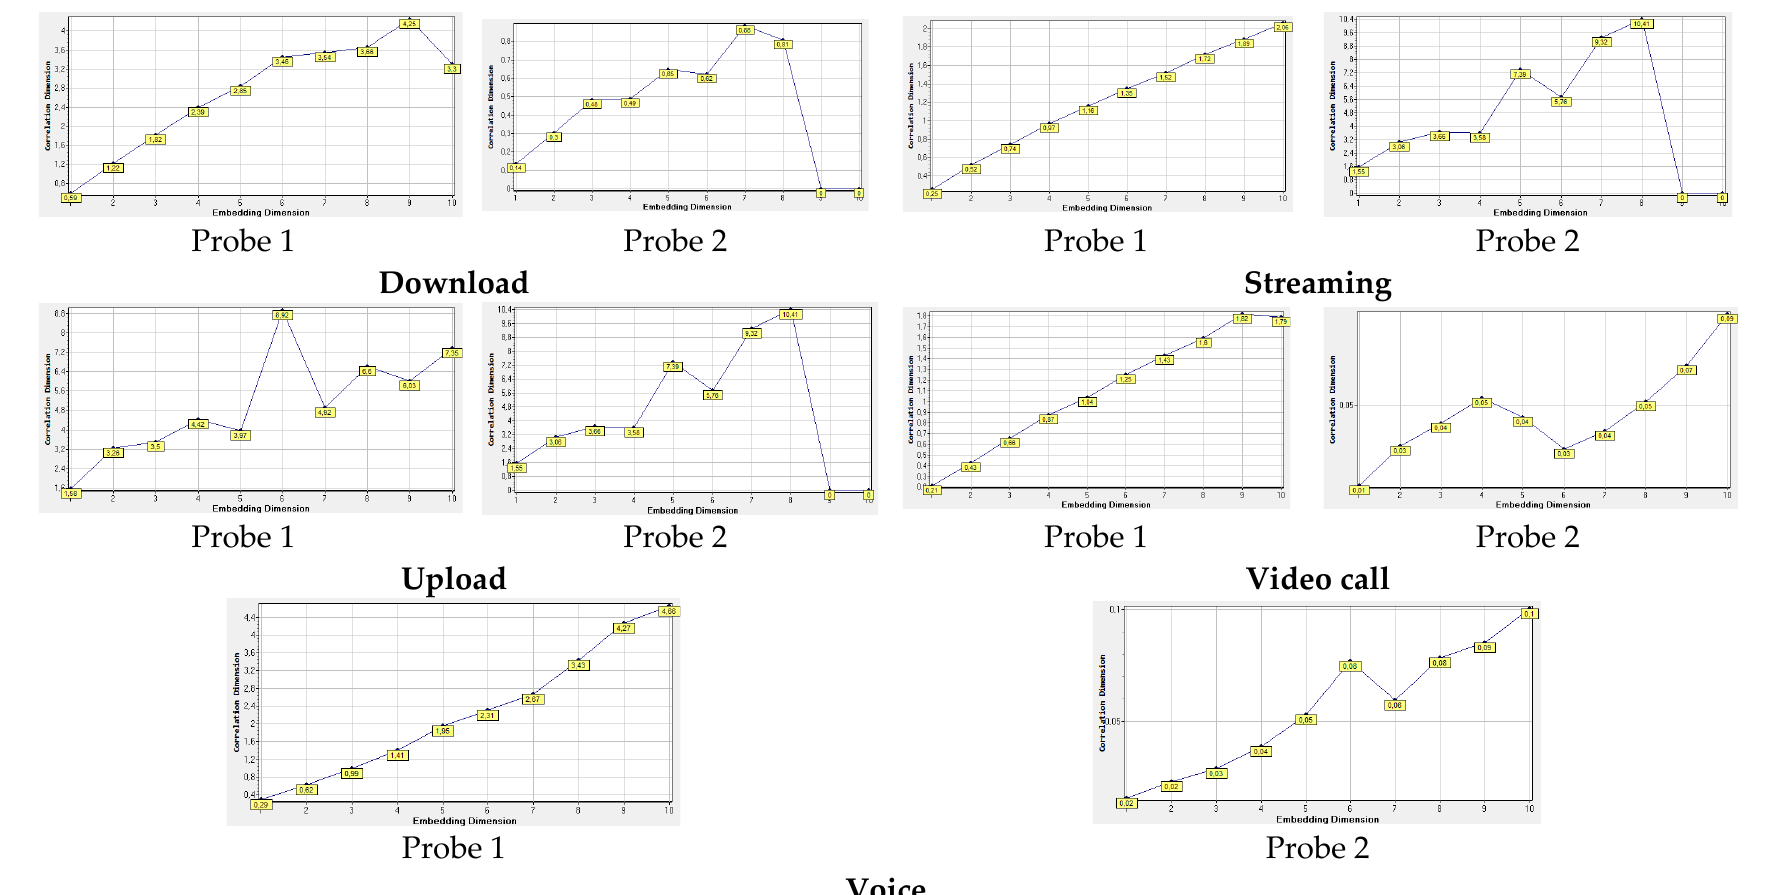
Figure 11. Correlation dimension charts corresponding to all five mobile applications for Probe 1 and Probe 2.